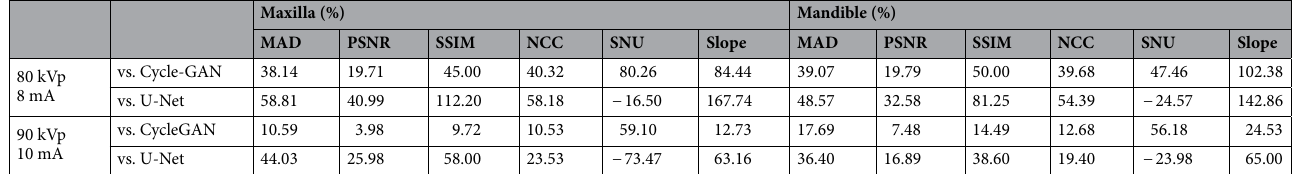
Table 2. Percentage increases of QCBCT-NET performance compared to Cycle-GAN and U-Net for measuring BMD values at the maxilla (1–81 slices) and mandible (82–200 slices) for CBCT images of test datasets under conditions of 80 kVp and 8 mA, and 90 kVp and 10 mA. MAD mean absolute difference, PSNR peak signal to noise ratio, SSIM structural similarity, NCC normalized cross correlation, SNU spatial nonuniformity, Slope slope of linear regression between the voxel